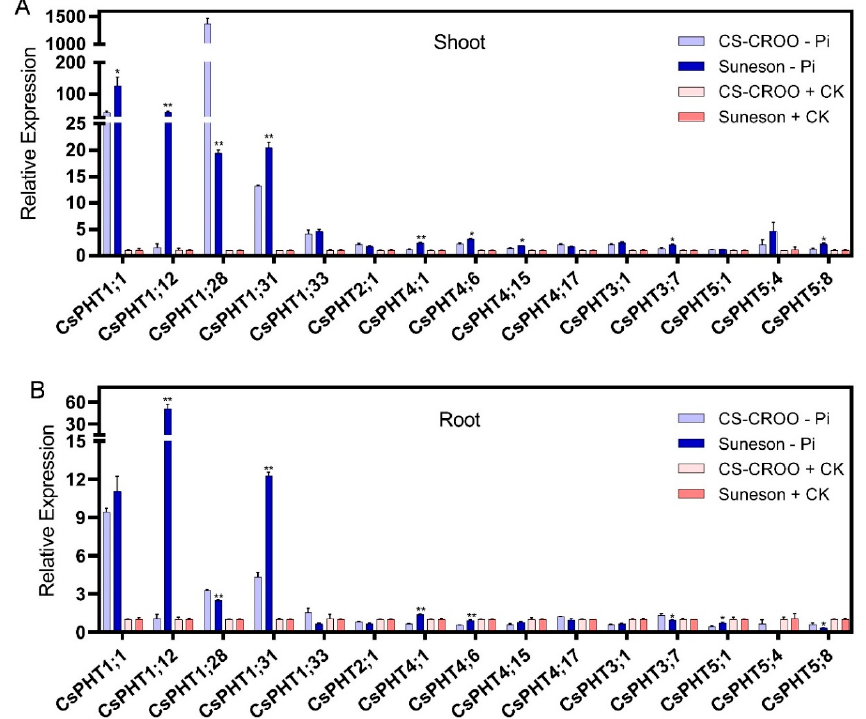
Figure 7. Expression analysis of 15 selected CsPHT genes in ( A ) Shoot and ( B ) Root of the low-P-sensitive CS-CROO and the low-P-tolerant Suneson treated under low-P (-Pi, 10 µM) and the control (CK, 312 µM) conditions for four weeks, as revealed by qRT-PCR. The mean ± SD of three biological replicates are presented. Asterisks indicate a significant difference (* p < 0.01 and ** p < 0.001) in gene expression between two Camelina accessions after Pi treatments.